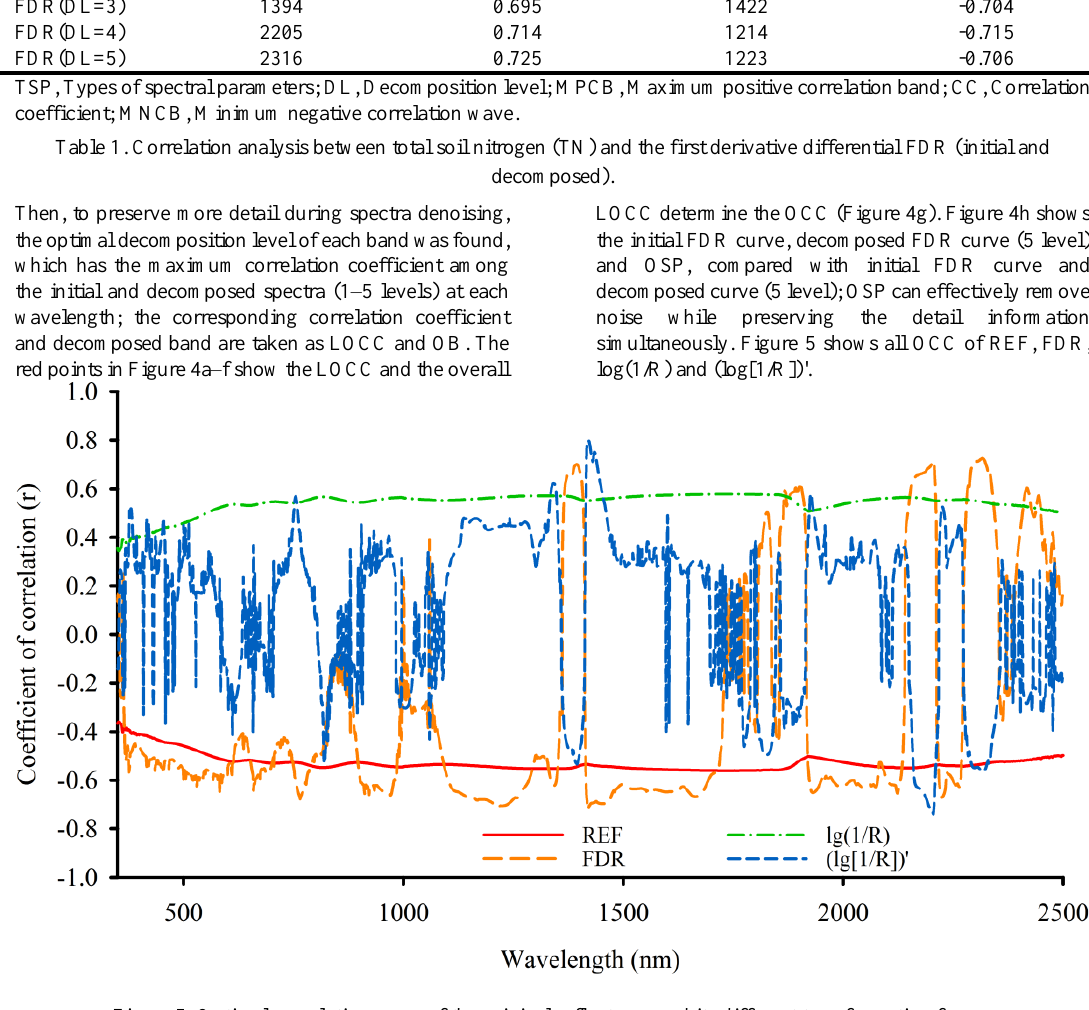
Figure 5. Optimal correlative curve of the original reflectance and its different transformation forms. Based on Figure 5, the OCC of (log[1/R])' performed better, and the correlation coefficient was 0.797. In addition, the OCC of FDR had more bands with high correlation than OCC of (log[1/R])'; meanwhile, its maximum correlation coefficient